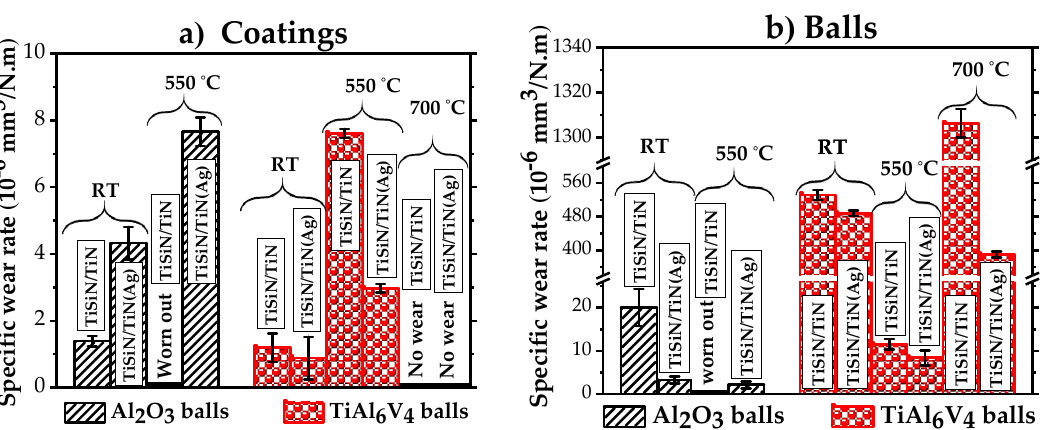
Figure 3. ( a ) Specific wear rate of the coatings tested against different balls, and ( b ) specific wear rate of Al 2 O 3 tested at RT and 550 °C and TiAl6V4 balls tested at RT, 550 and 700 °C.